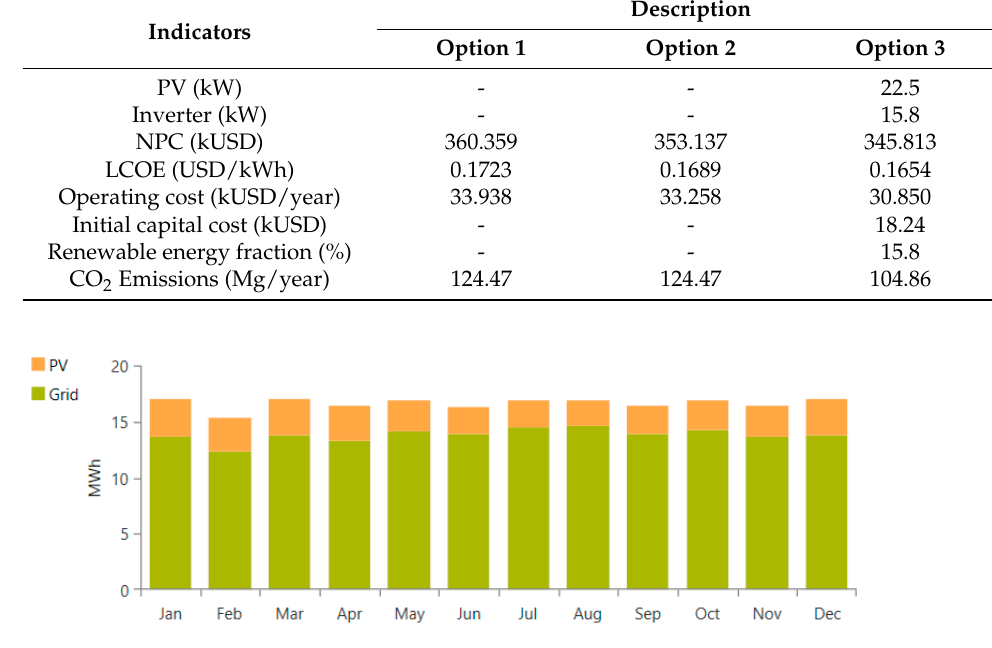
Figure 10. Average energy production per month for option 3. Table 5. Several indicators of economic analysis with different tariff options in the case study.